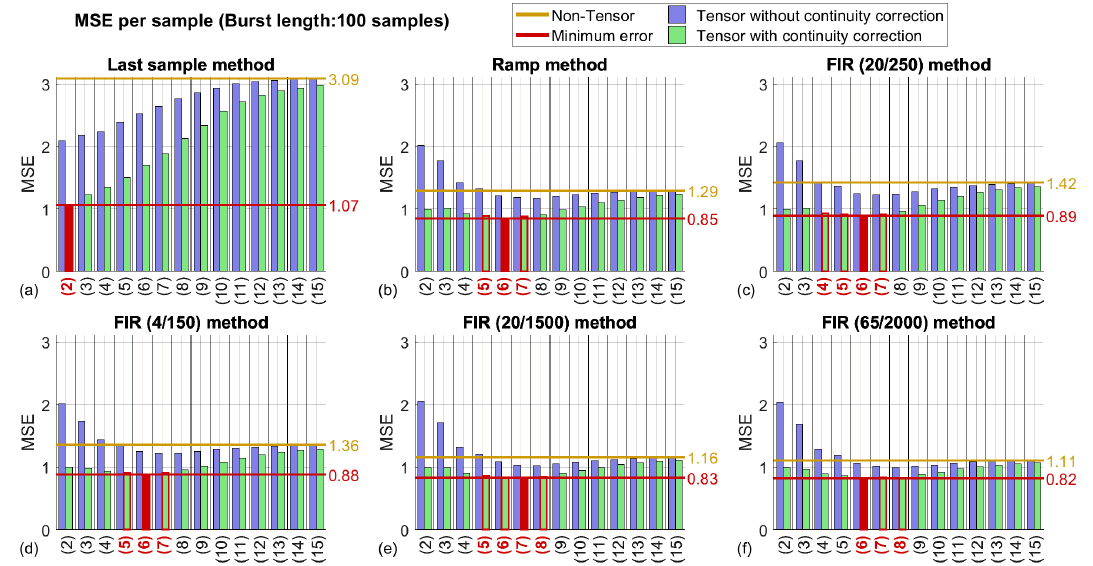
Figure 11. MSE per sample of the CP decomposition depending on the core tensor. The MSE of the restoration is shown with the continuity correction and without it. The bars marked in red have an error of no bigger than 5% of the